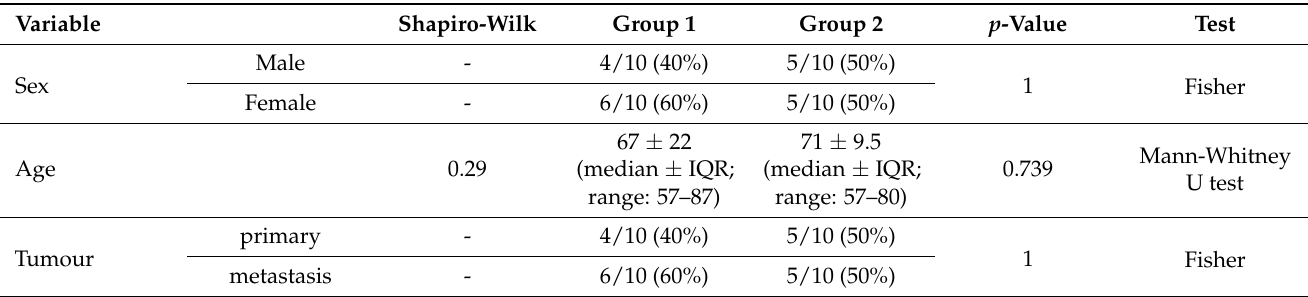
Table 1. Statistical analysis. IQR: interquartile range; SD: Standard